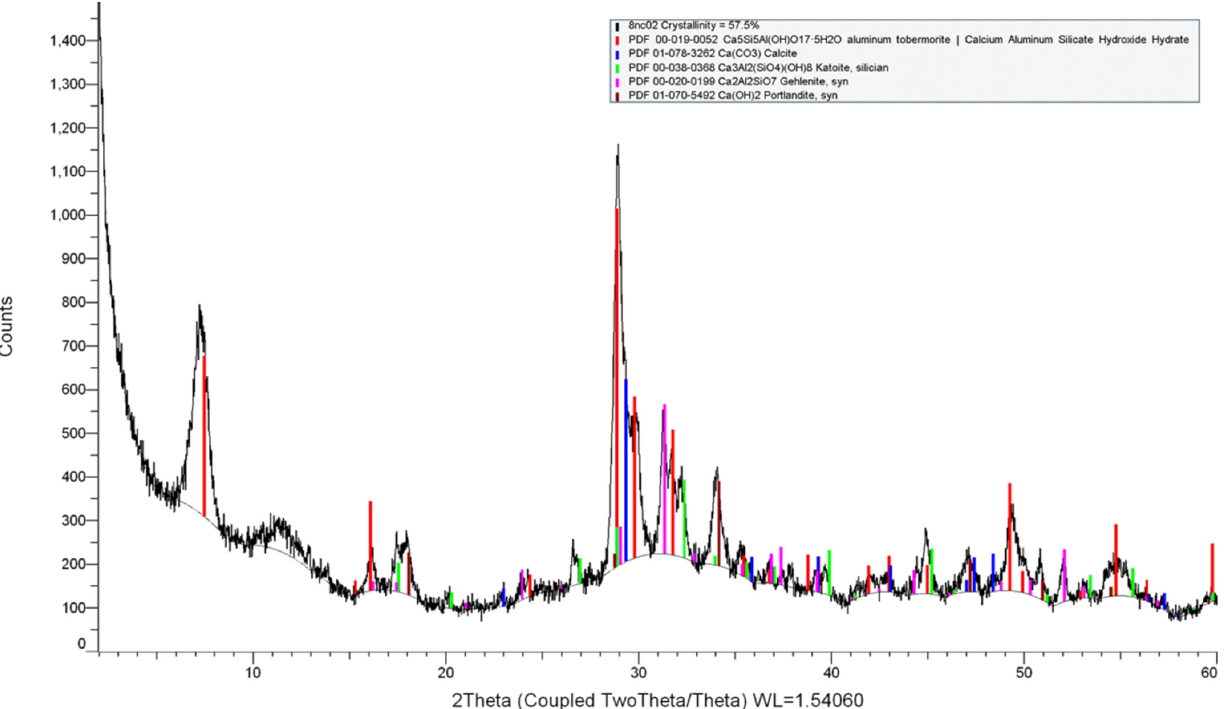
Figure A1. XRD pattern of TOB-2 showing the identification of reflections from 11 Å tobermorite (PDF ® 00-019-0052, red lines), katoite (PDF ® 00-038-0368, green lines), portlandite (PDF ® 01-070-5492, brown lines), calcite (PDF ® 01-078-3262, blue lines), and gehlenite (PDF 00-020-0199, pink lines).